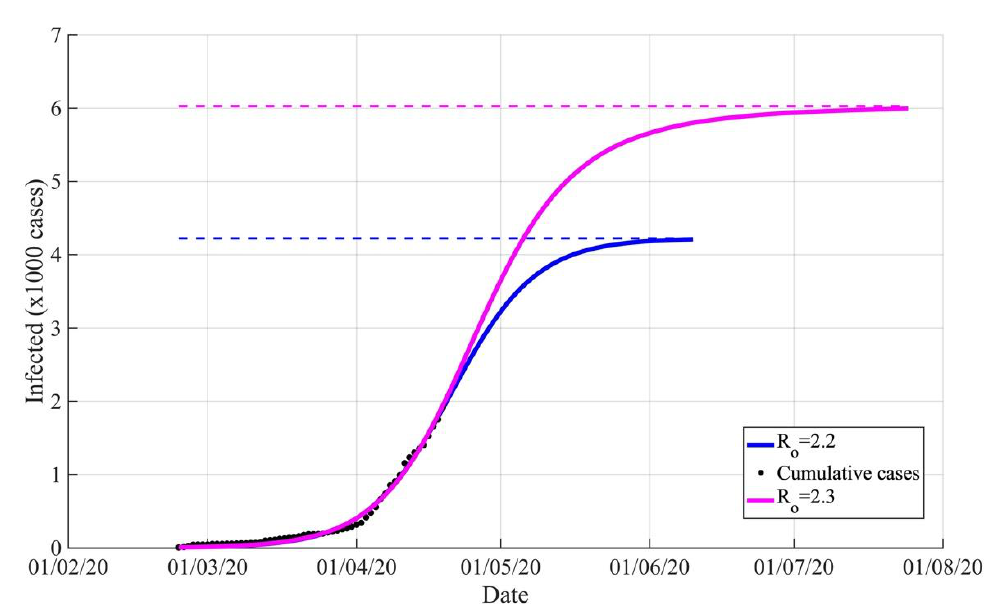
Figure 5. Predicted cumulative infections with various reproduction numbers of ⁡𝑅 𝑜 = 2.2 and ⁡𝑅 𝑜 = 2.3 .